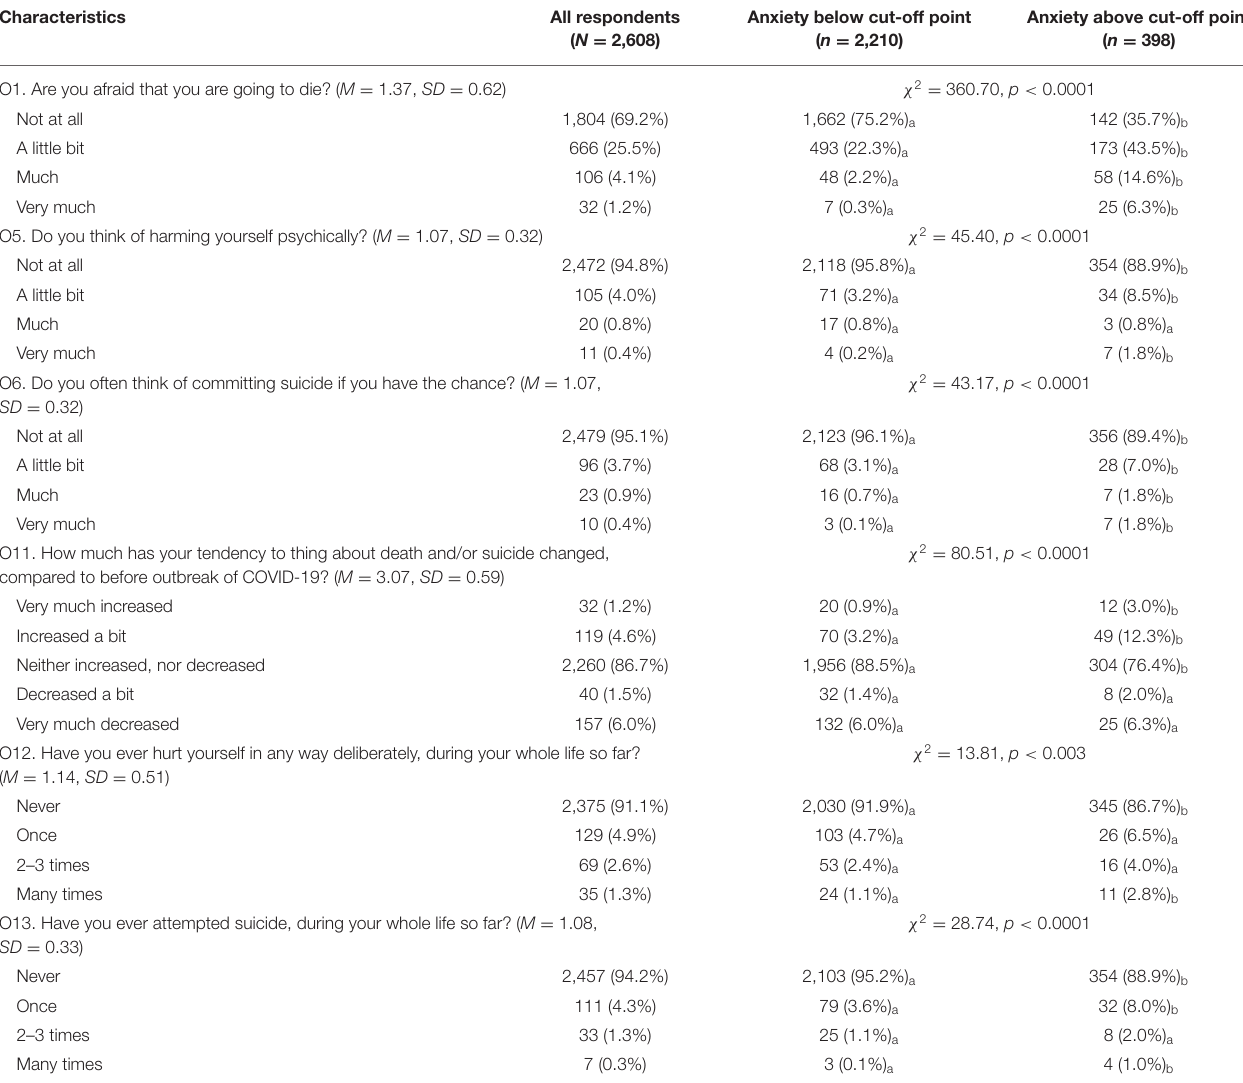
TABLE 3 | The association of anxiety and suicidality and self-harm history in the general population of Latvia during the COVID-19 state of emergency ( n = 2,608).